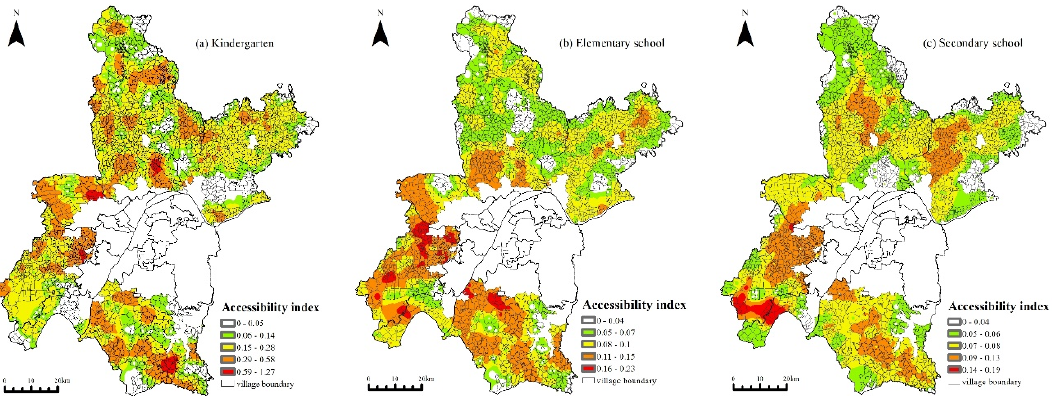
Figure 4. Spatial accessibility of rural basic education resources in Wuhan City’s new urban districts. Table 4. Index of accessibility of rural basic educational resources in Wuhan City’s new urban districts.